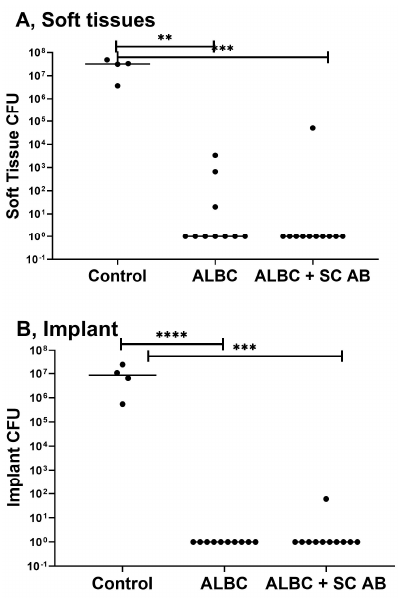
Figure 4. Results of local antibiotic prophylaxis phase. Results are grouped according to sample type for the control group (n = 4) and groups with ALBC with (n = 10) or without (n = 11) additional antibiotics. ( A ) Soft tissue sample, ** statistical significance between the control group and group with ALBC without additional antibiotics ( p = 0.004), *** statistical significance between the control group and group with additional antibiotics ( p = 0.0005); ( B ) Implant sample, *** statistical significance between the control group and group with additional antibiotics ( p = 0.0002), **** statistical significance between the control group and group with ALBC without additional antibiotics ( p < 0.0001). The CFU count is presented on the y ‐ axis. The x ‐ axis is reflecting the implant type, as well as additionally administered systemic antibiotic prophylaxis.